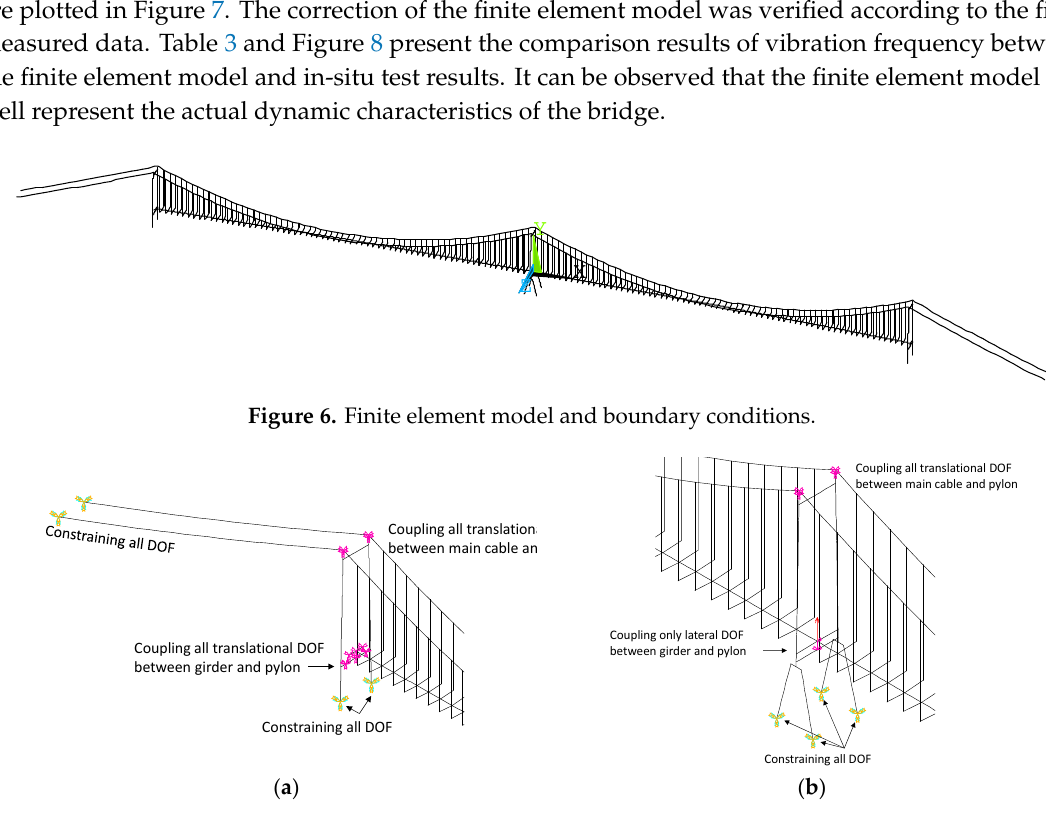
Figure 7. Details of boundary conditions. ( a ) near side pylon, ( b ) near middle pylon.